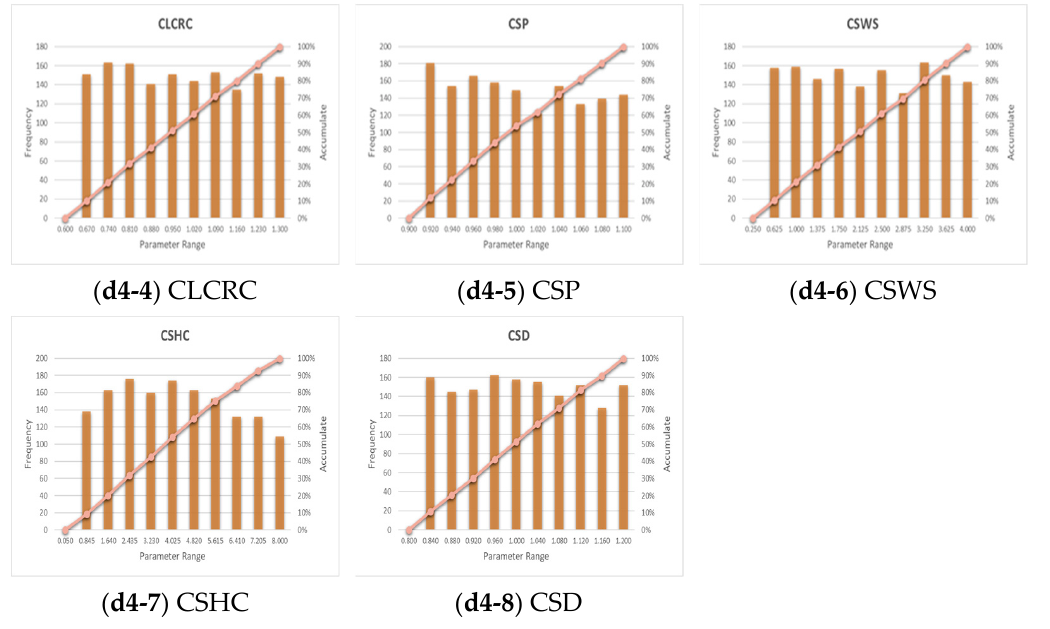
Figure 8. Event 2 parameter sensitivity (histogram/CDF). ( a4-1 – a4-8 ) LNSE results; ( b4-1 – b4-8 ) LPBIAS results; ( c4-1 – c4-8 ) LRSR results; ( d4-1 – d4-8 ) LLOG results.